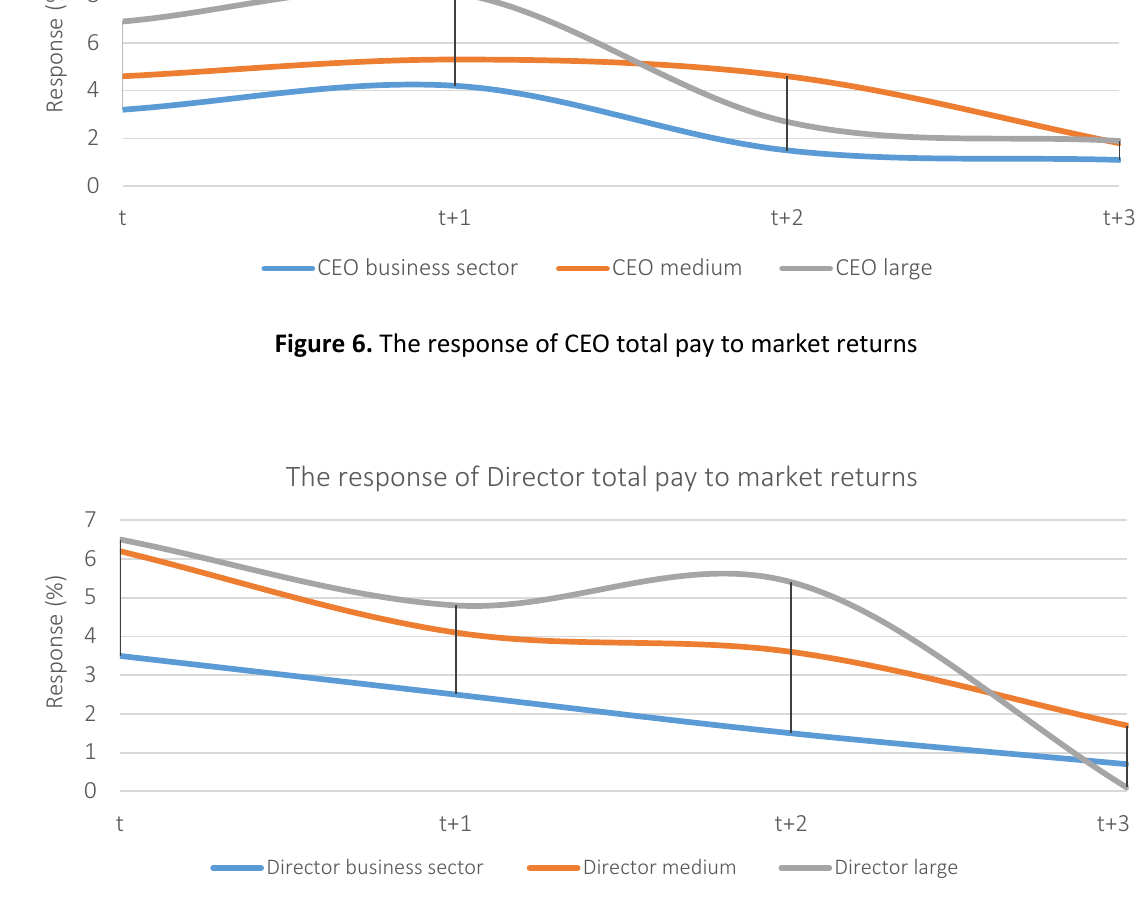
Figure 7. The response of Director total pay to market